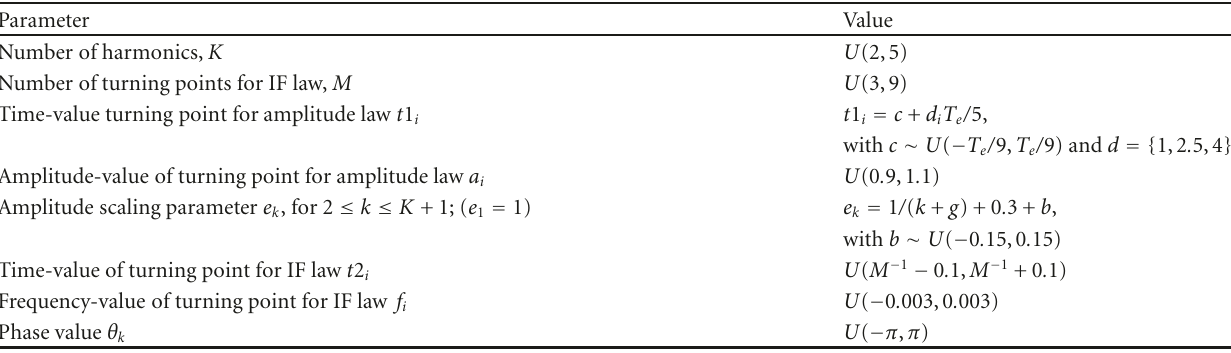
Table 1: Parameter values to generate the slowly-varying periodic signal with K harmonic components. All parameters are generated from a uniform probability distribution U ( a , b ), where a , b represent the lower and upper limits of the distribution. The subscript k represents the k th harmonic component and T e is the length in seconds of the signal. The parameter g defines the relative energy in the harmonic